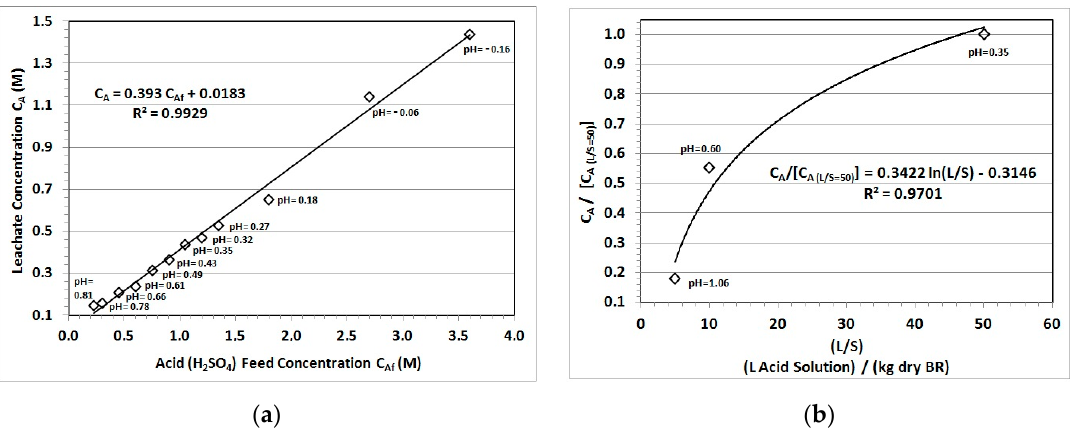
Figure 4. ( a ) Variation of leachate acid concentration ( M ) with feed acid (sulfuric) concentration, for constant L/S = 50 (L/kg), τ = 60 min, mechanical stirring and ambient conditions. The equation of LSRL fitting, R 2 and the respective measured pH values are appended. C A has been calculated from pH with use of p Κ a 1 = − 3 and pK a 2 = 1.99; ( b ) Variation of leachate acid concentration with L/S , as fraction of the respective concentration at L/S = 50, when feed acid concentration is 1.05M and under conditions of (a). Equation of ln-LSR fitting, R 2 and the respective pH values are appended.